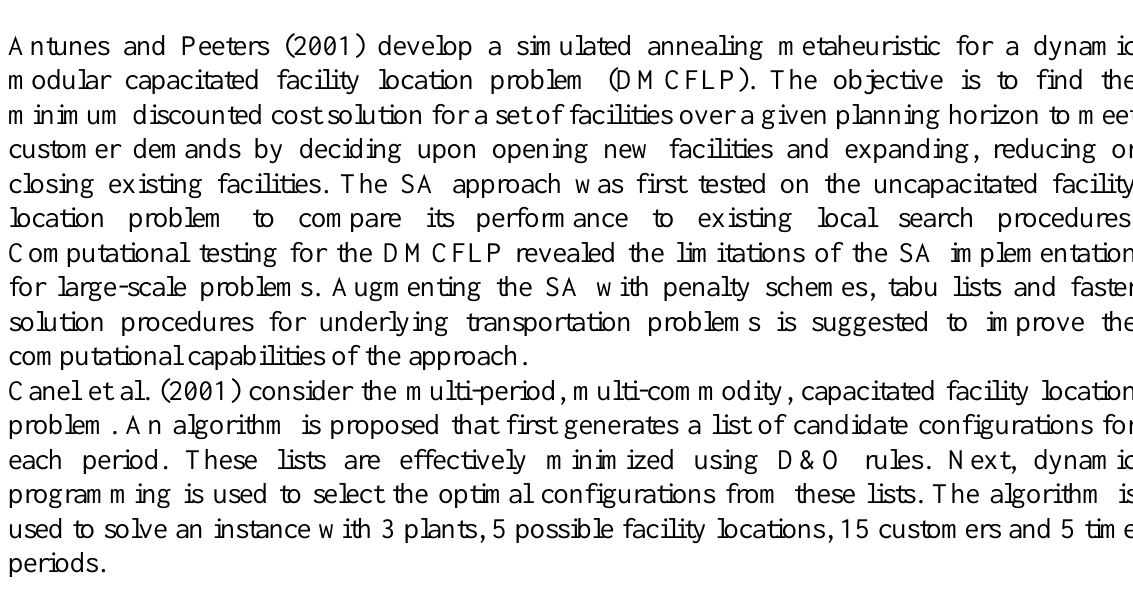
Table 1. Production facility